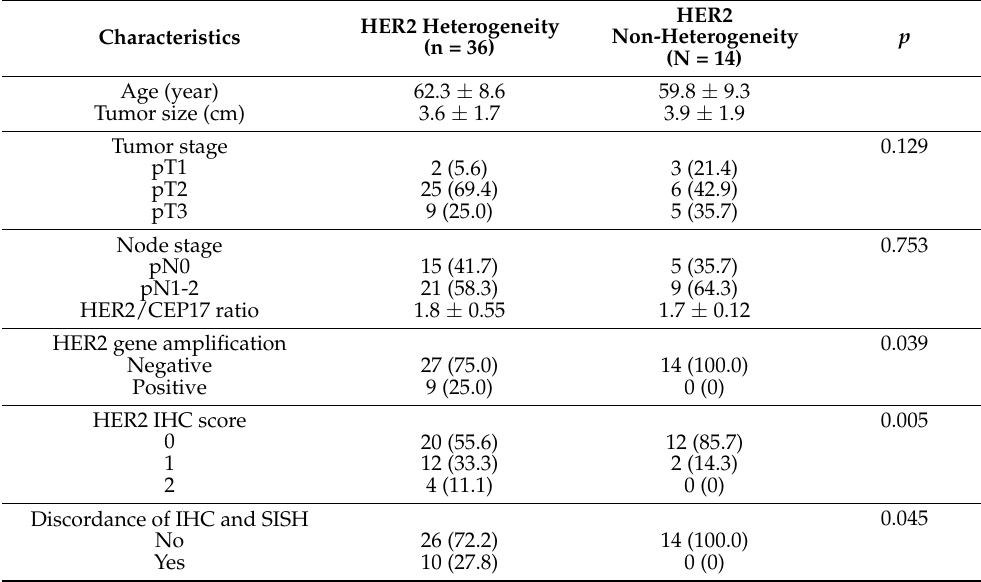
Table 3. Clinicopathologic correlation of pancreatic adenocarcinoma with HER2-neg and HER2-low and intra-tumoral genetic